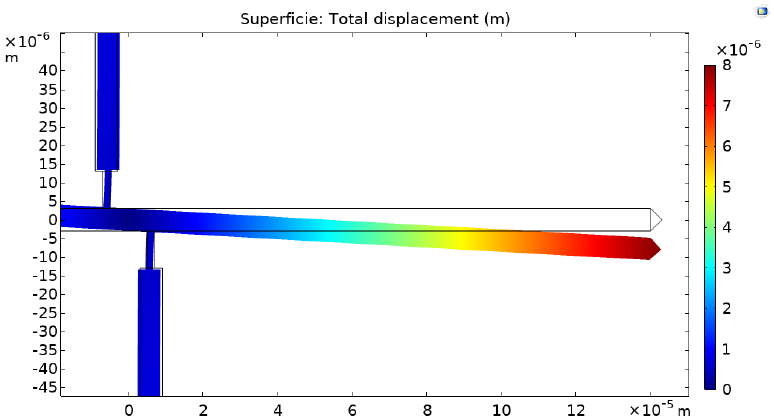
Figure 13. Shift of strain gauge indicating bar (sample P2) after release from the substrate.